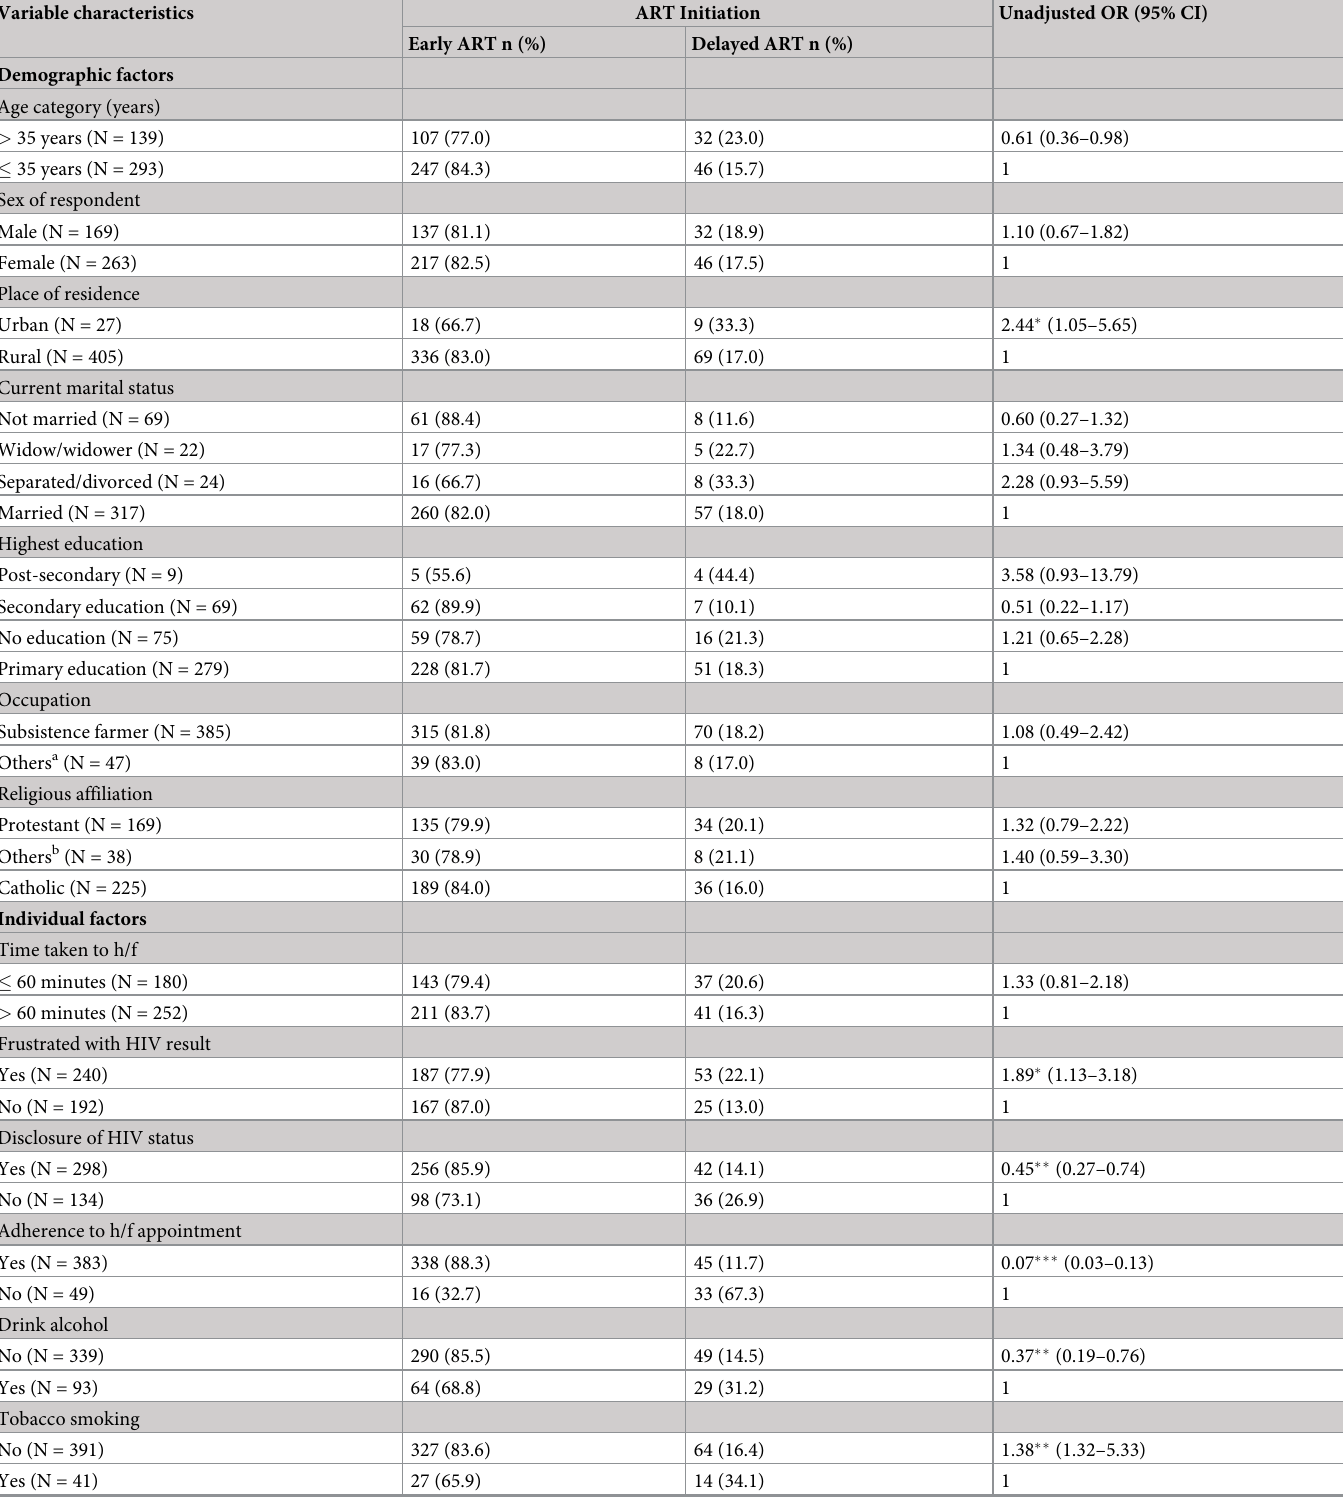
Table 3. Unadjusted analysis of factors and delayed ART initiation among adults with